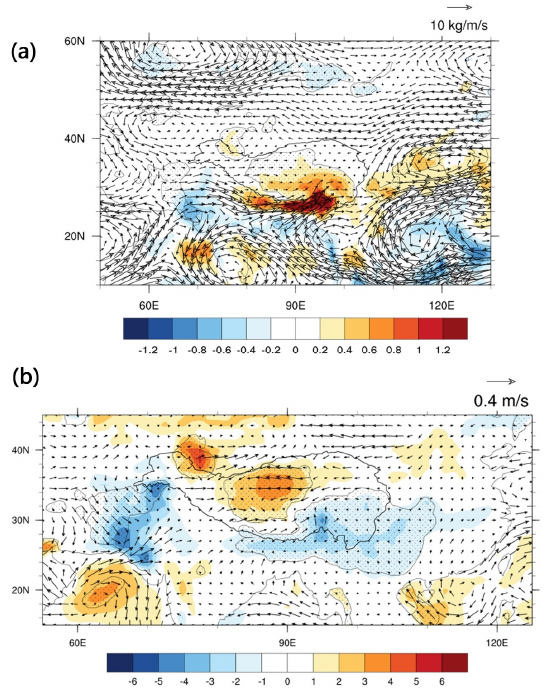
Figure 14. Anomalies of ( a ) the water vapor flux (vector, unit: kg m − 1 s − 1 ) and precipitation (colored shading, unit: mm d − 1 ), ( b ) SLHF (colored shading, unit: W m − 2 ), and sea surface wind field (vector, unit: m s − 1 ) regressed on the detrended and standardized time series of summer WVB from 1958 to 2019.